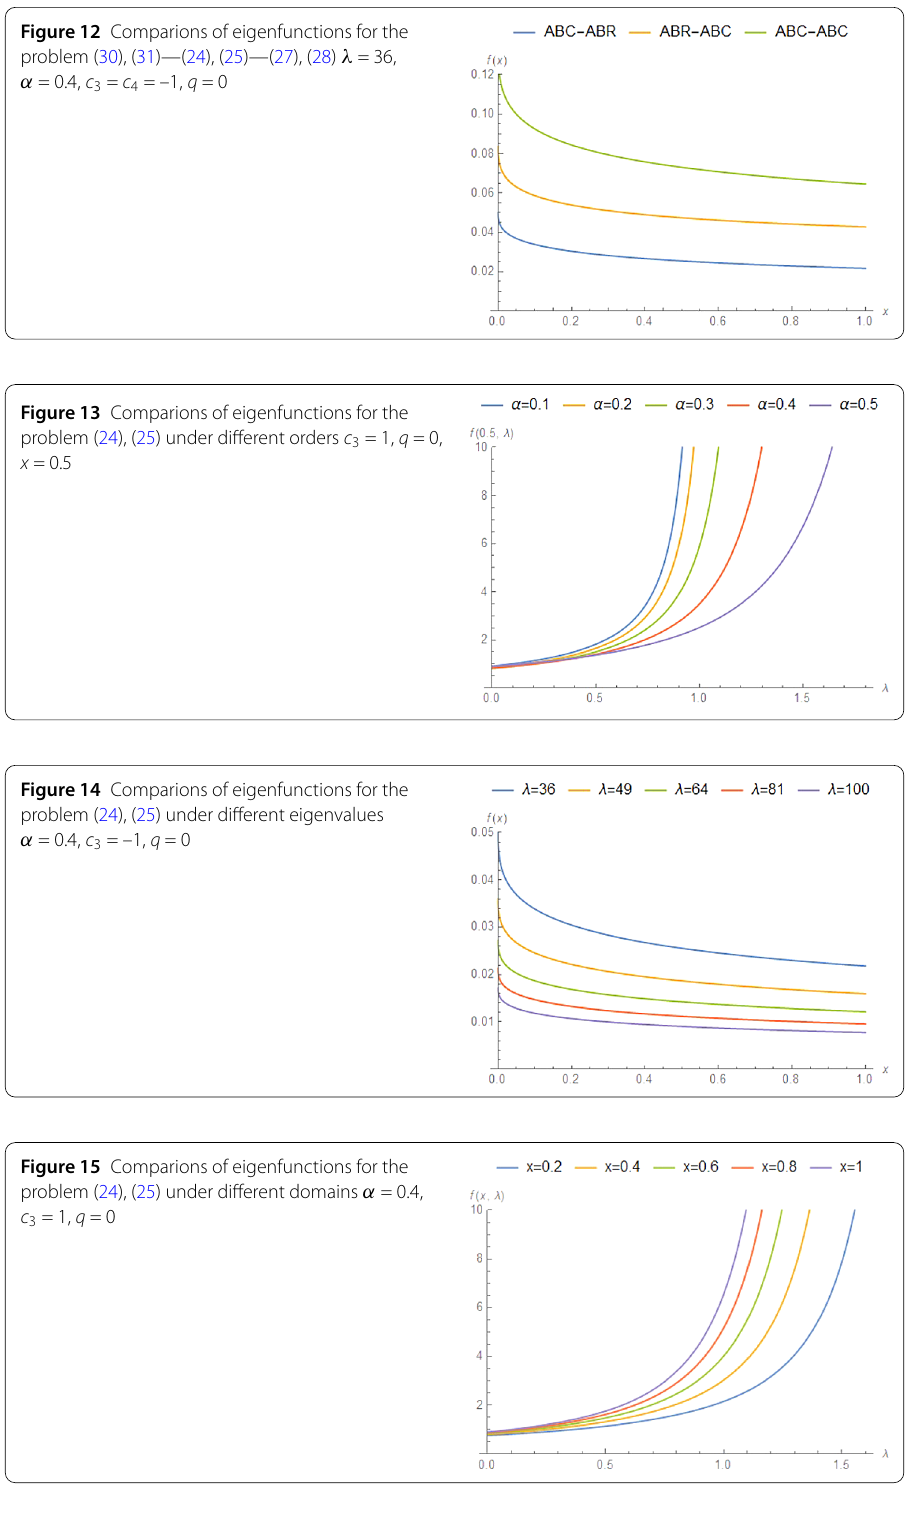
Eigenvalues of problem (24)–(25) corresponding to some specific eigenfunctions are given with different orders in Table 1 and Table 2. Finally, we compare the eigenfunctions of problems (12)–(13) and (24)–(25) with different orders in Fig. 17, Fig. 18, and Fig.